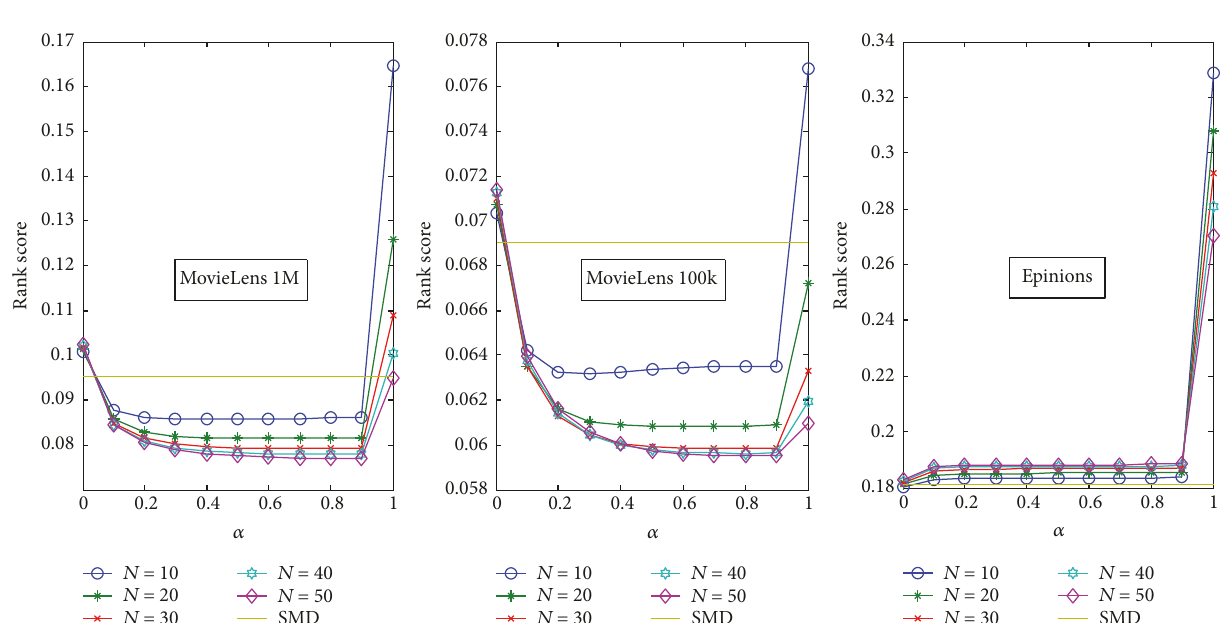
Figure 3: The overall ranking score of the NNMD algorithm under different 𝑁 and 𝛼 in MovieLens 100k, MovieLens 1M, and Epinions data set and the ranking score of the SMD algorithm in MovieLens 100k, MovieLens 1M, and